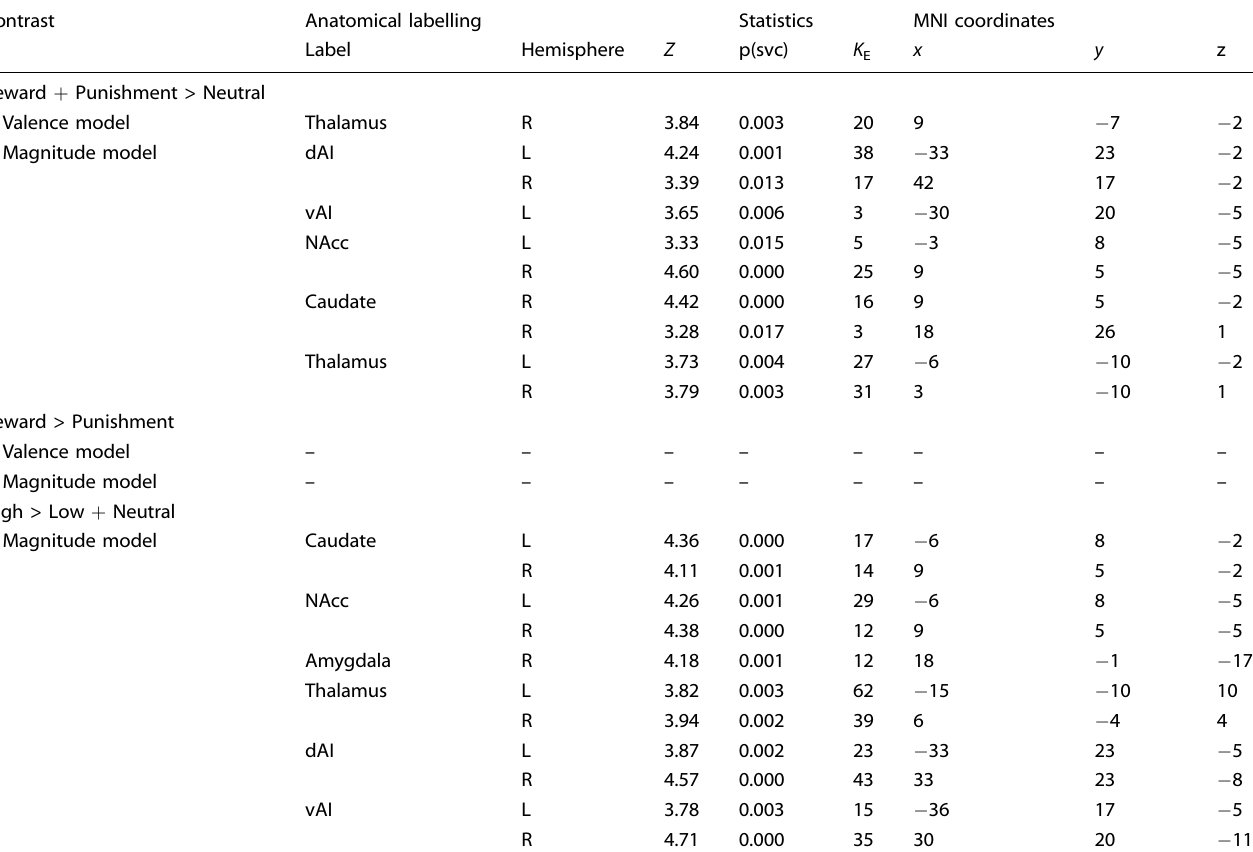
Table 2. Region of interest (ROI) validation analysis for the three contrasts using the valence and magnitude cue models.